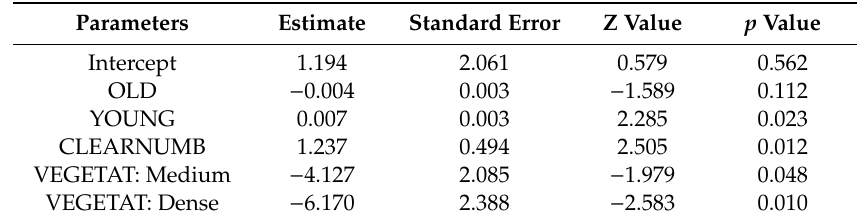
Table 3. Estimates of model coe ffi cients for the best general linear models (GLM) of Nightjar occurrence.